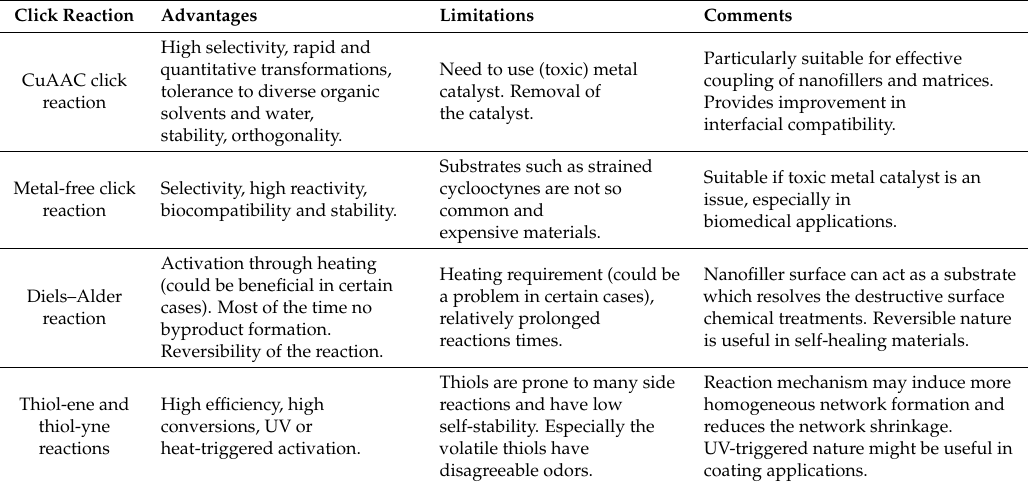
Table 1. Main advantages and associated limitations of commonly employed click reactions in polymer nanocomposite